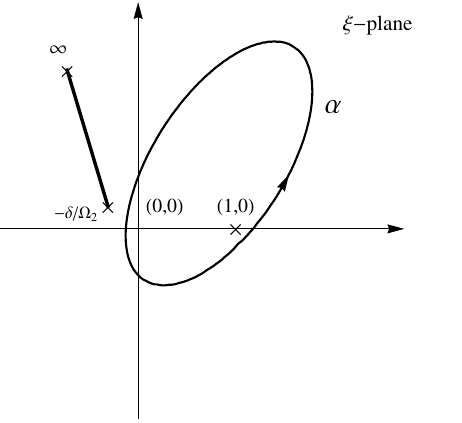
Figure 3 . Integral contour for (E.1). Figure 4 . Integral contour for (E.2).